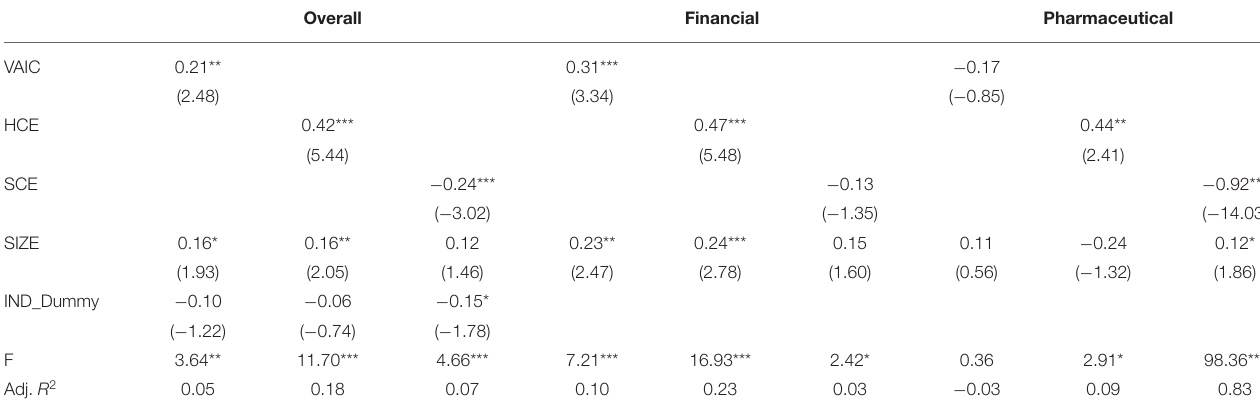
TABLE 3 | Multiple regressions of ROA on VAIC and its components. Overall Financial